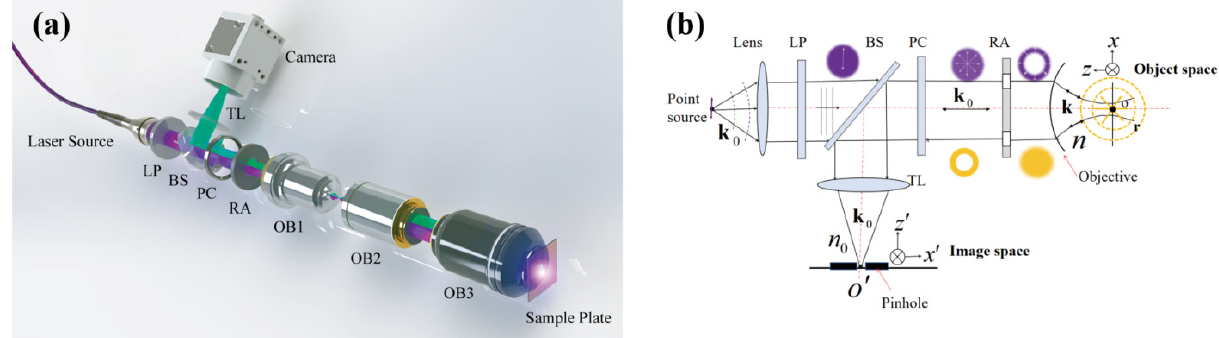
Figure 1. ( a ) A schematic diagram and ( b ) the optical path of the proposed far-field and non-intrusive CLSM system. The purple illustrations above the excitation system and yellow ones under the detection system, respectively, denote the morphology of optical field during the modulation processes. LP: linear polarizer; BS: beam splitter; PC: polarization converter; RA: ring aperture; OB: objective; TL: tube lens.